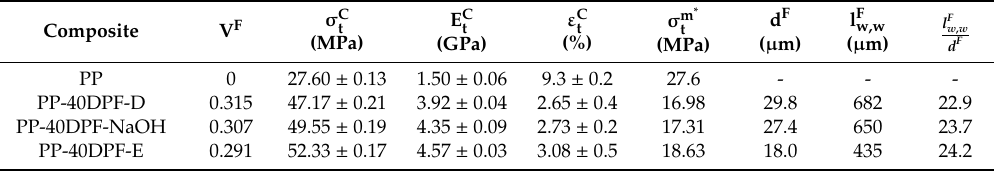
Table 1. Mechanical properties of 40% w / w Date palm fibers—PP composites.